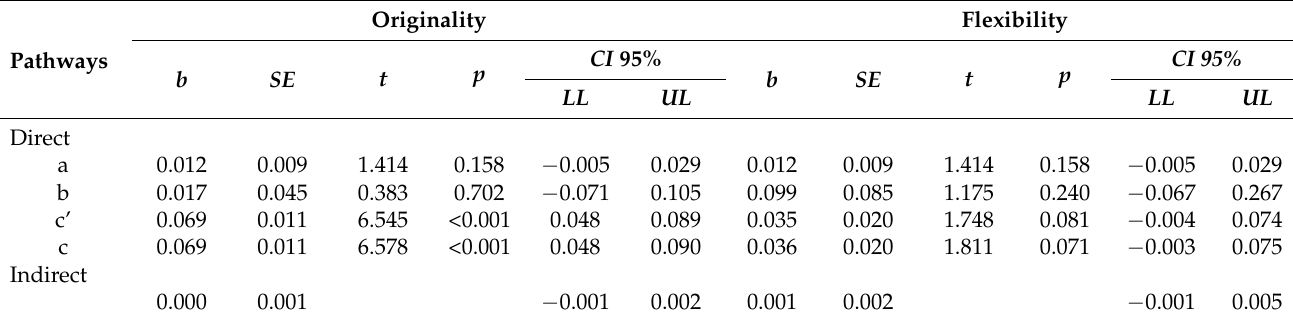
Table 2. Direct and indirect effects coefficients of the mediation analyses of the relationship between the probability of conception and creative originality and flexibility, with arousal as a mediator and age as a controlled variable. Originality Pathways